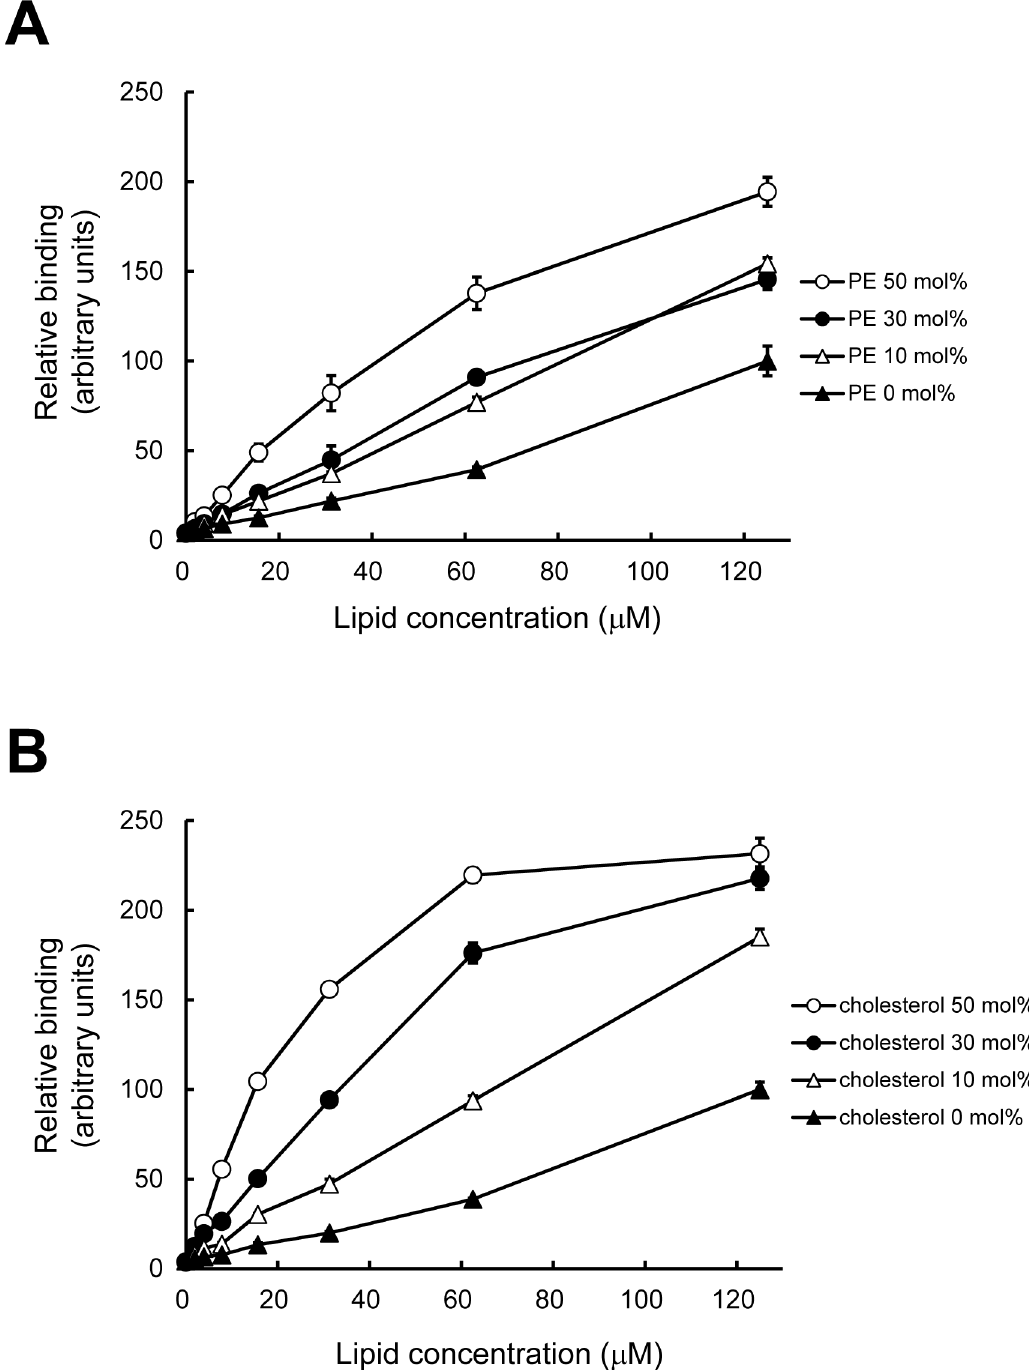
Fig 3. Effect of PE and cholesterol on the binding of PAB-TP to PA-containing vesicles. (A) Binding of PAB-TP to LUVs composed of DOPA/DOPC/ biotin-DOPE/DOPE (10:88:2:0), (10:78:2:10), (10:58:2:30), and (10:38:2:50) was examined by the SPVB assay (mean ± SE, n = 3). (B) Binding of PAB-TP to LUVs composed of DOPA/DOPC/biotin-DOPE/cholesterol (10:88:2:0), (10:78:2:10), (10:58:2:30), and (10:38:2:50) was examined by the SPVB assay (mean ± SE, n = 3). (A, B) The binding of LUVs composed of DOPA/DOPC/biotin-DOPE (10:88:2) at the concentration of 125 μ M to PAB-TP was represented as 100 (arbitrary